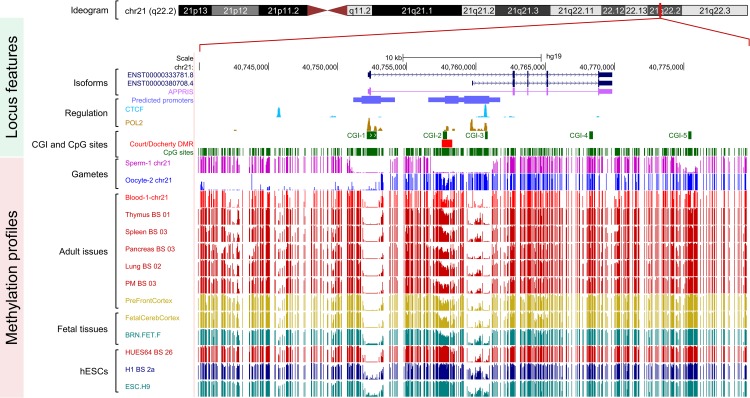
The methylation statuses at the CpG islands of the WRB gene in methylome public datasets.Chromosomal, physical map positions and sequence features of the reference WRB gene locus showing the methylation profiles across the region, with an emphasis on the five annotated CpG islands (CGI-1 to CGI-5). The features depicted are from custom and public tracks for (from top to bottom) the exon organization of the principal (ENST00000333781.8) and alternative (ENST00000380708.4) splice WRB isoforms (variants 1 and 2 in dark blue) (UCSC Genes [36]), the species-conserved principal transcript (ENST00000333781 in pink) (APPRIS [75]), the Ensembl Regulatory Build CTCF and POL2 activity and predicted promoters [76], CpG islands, CpG sites, and regulation and methylome studies indicated in the Materials and Methods section. The CGI-2 is located in the differentially methylated region (DMR) reported by Court and collaborators [24] and Docherty and collaborators [25] (depicted in red in the custom track named Court/Docherty DMR), from which WRB was classified originally as a novel candidate, maternally imprinted gene (i.e., paternal-origin allele expressed). The custom tracks containing the sperm and oocyte DNA methylation signals correspond to the supplementary data reported by Okae et al. [46]. Screenshot generated using the UCSC Genome Browser hg19 (http://genome.ucsc.edu).